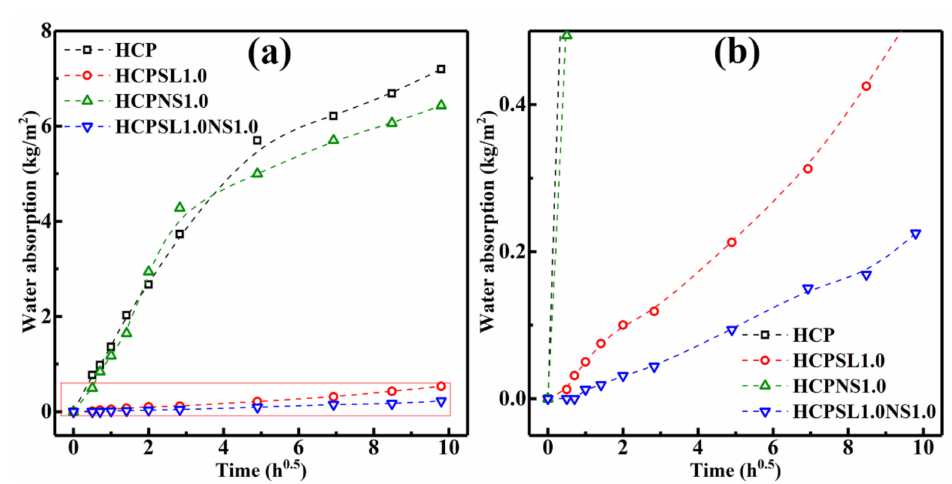
Figure 8. Water absorption measurement of the four kinds of HCPs; ( b ) is a partial enlargement of ( a ).